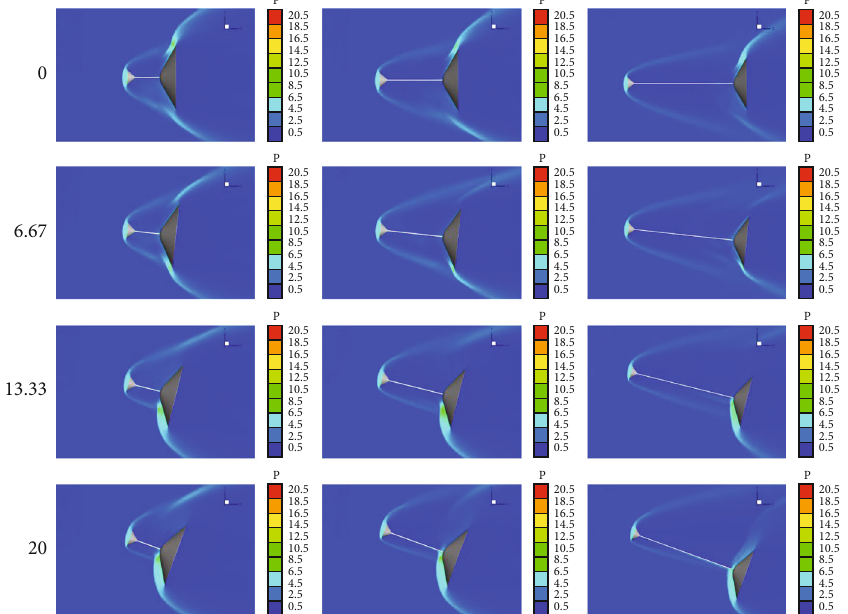
Figure 10: Development of the fl ow- fi eld density contour with di ff erent L / D .